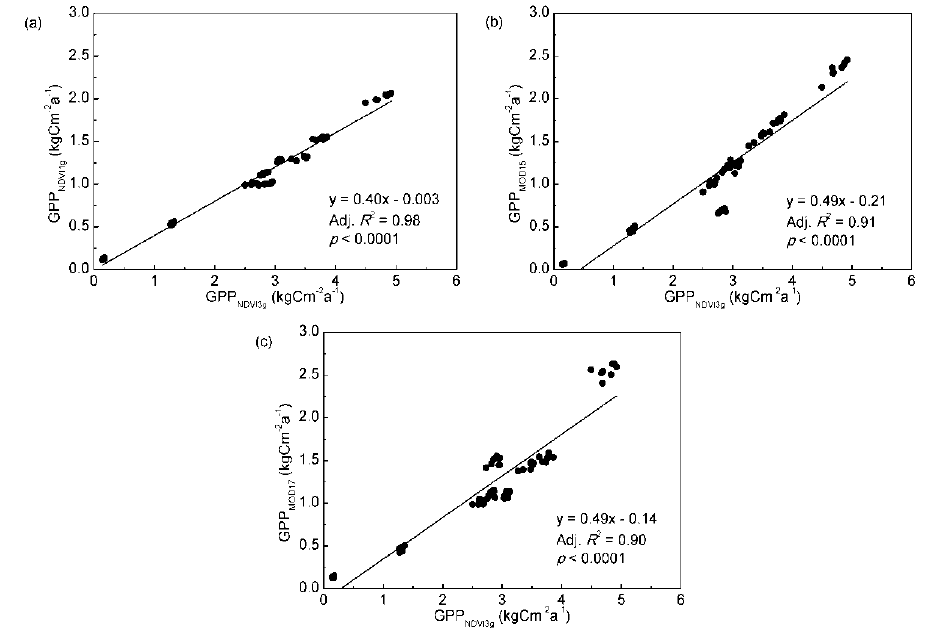
Figure 6. Scatter plots of annual GPP between the GIMMS NDVI3g based GPP (GPP ) and ( a ) MOD15A2 based GPP (GPP NDVI3g (GPP ); ( c ) the MODIS GPP product MOD17A2 (GPP NDVI1g